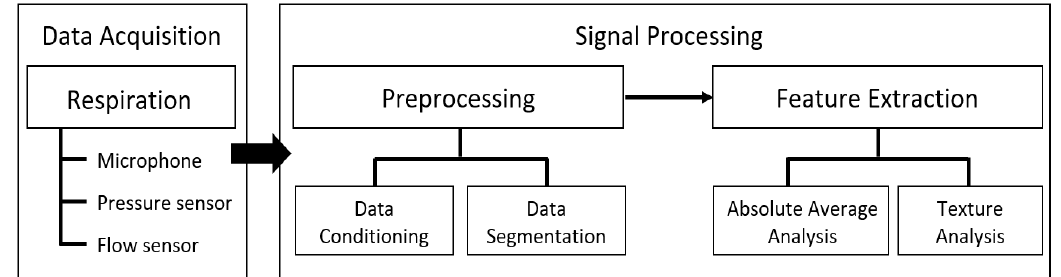
Figure 4. Flowchart of respiratory signal analysis.